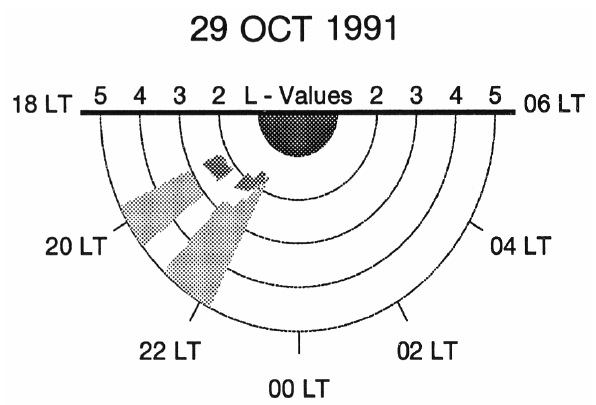
Fig. 13. Locations of the SAR arc (dark shading) and the diffuse au- Figure 13. Locations of the SAR arc (dark shading) and the diffuse aurora (light shading) rora (light shading) mapped to the magnetospheric equatorial plane mapped to the magnetospheric equatorial plane for all available 6300 Å images at for all available 6300 ˚A images at Millstone Hill on the night of 29 Millstone Hill on the night of 29 October 1991. Mapping of the SAR arc was October 1991. Mapping of the SAR arc was done for an ionospheric done for an ionospheric emission height of 400 km, while the diffuse aurora were emission height of 400km, while the diffuse aurora were mapped mapped from a height of 200 km. from a height of